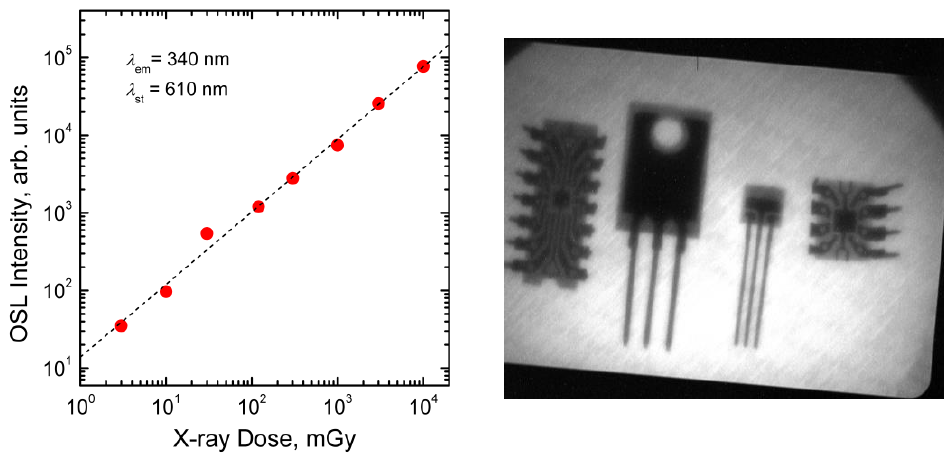
Figure 4. Experimental demonstrations of SHAPAL ® AlN ceramic plate for use as an OSL dosimeter. ( left ) Dose response curve of OSL in an AlN ceramic plate. The stimulation light wavelength is 610 nm while the emission light is 340 nm; ( right ) X-ray image of some electronic components taken by OSL of AlN ceramic plate. The stimulation light used here is 630 nm ± 50 nm. The electronic components are (from left to right): logic gate, field effect transistor, bipolar transistor, and operational amplifier.